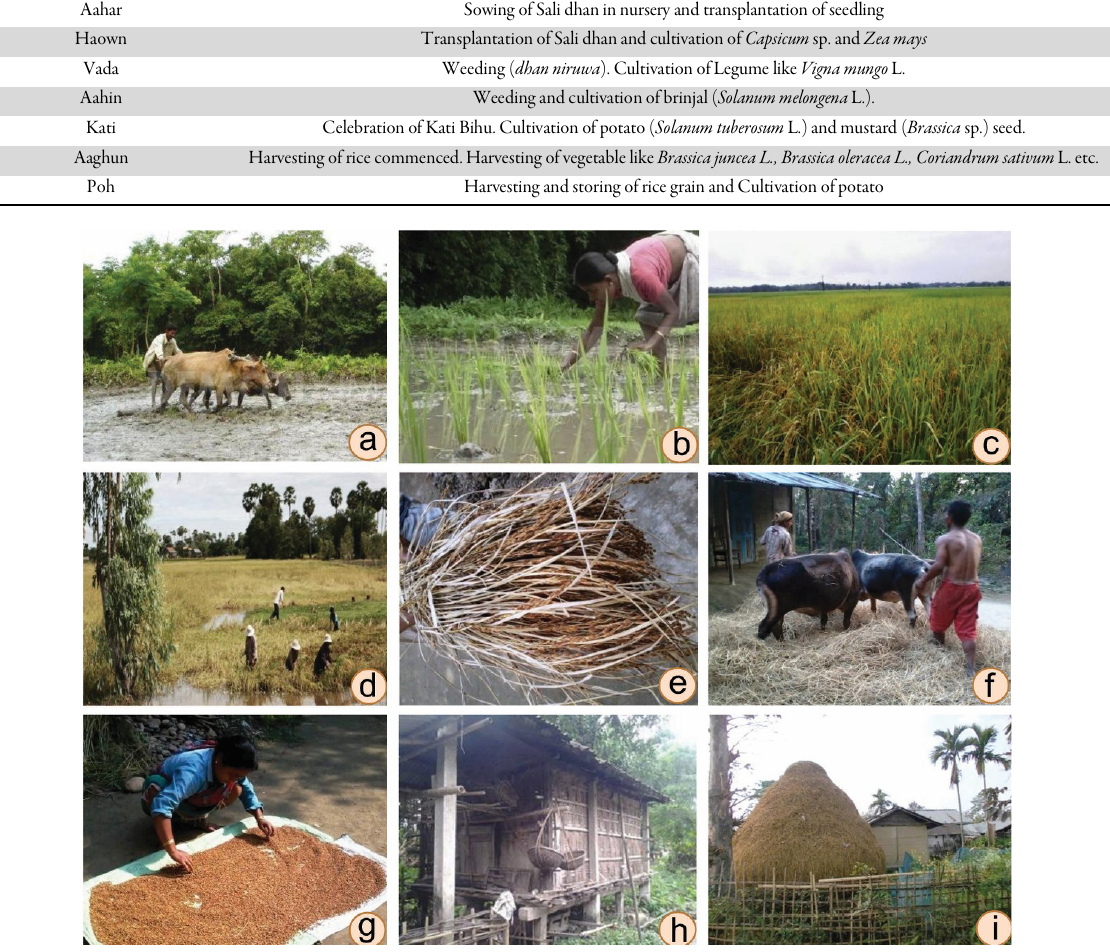
Fig. 3. Phases of Paddy cultivation in Lakhimpur, Assam: a). Preparation of field, b). Transplantation of seedlings, c). Mature paddy field (Sali-dhan), d). Harvesting of Bora-dhan, e). Bunch of harvested paddy, f). Thrashing (Morona), g). sundrying of grains, h) Traditional granary for storage of seeds, i). Pile of straw (fodder for